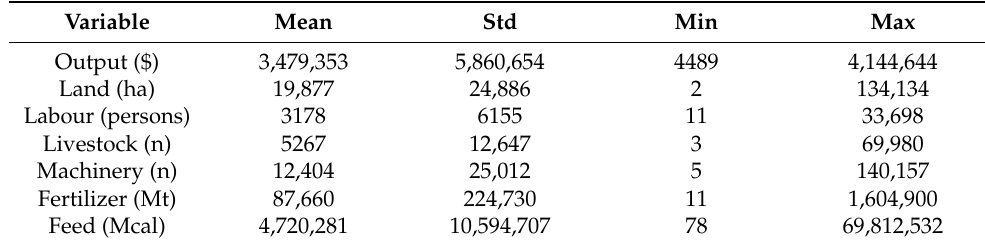
Table 1. Summary of output and input variables,